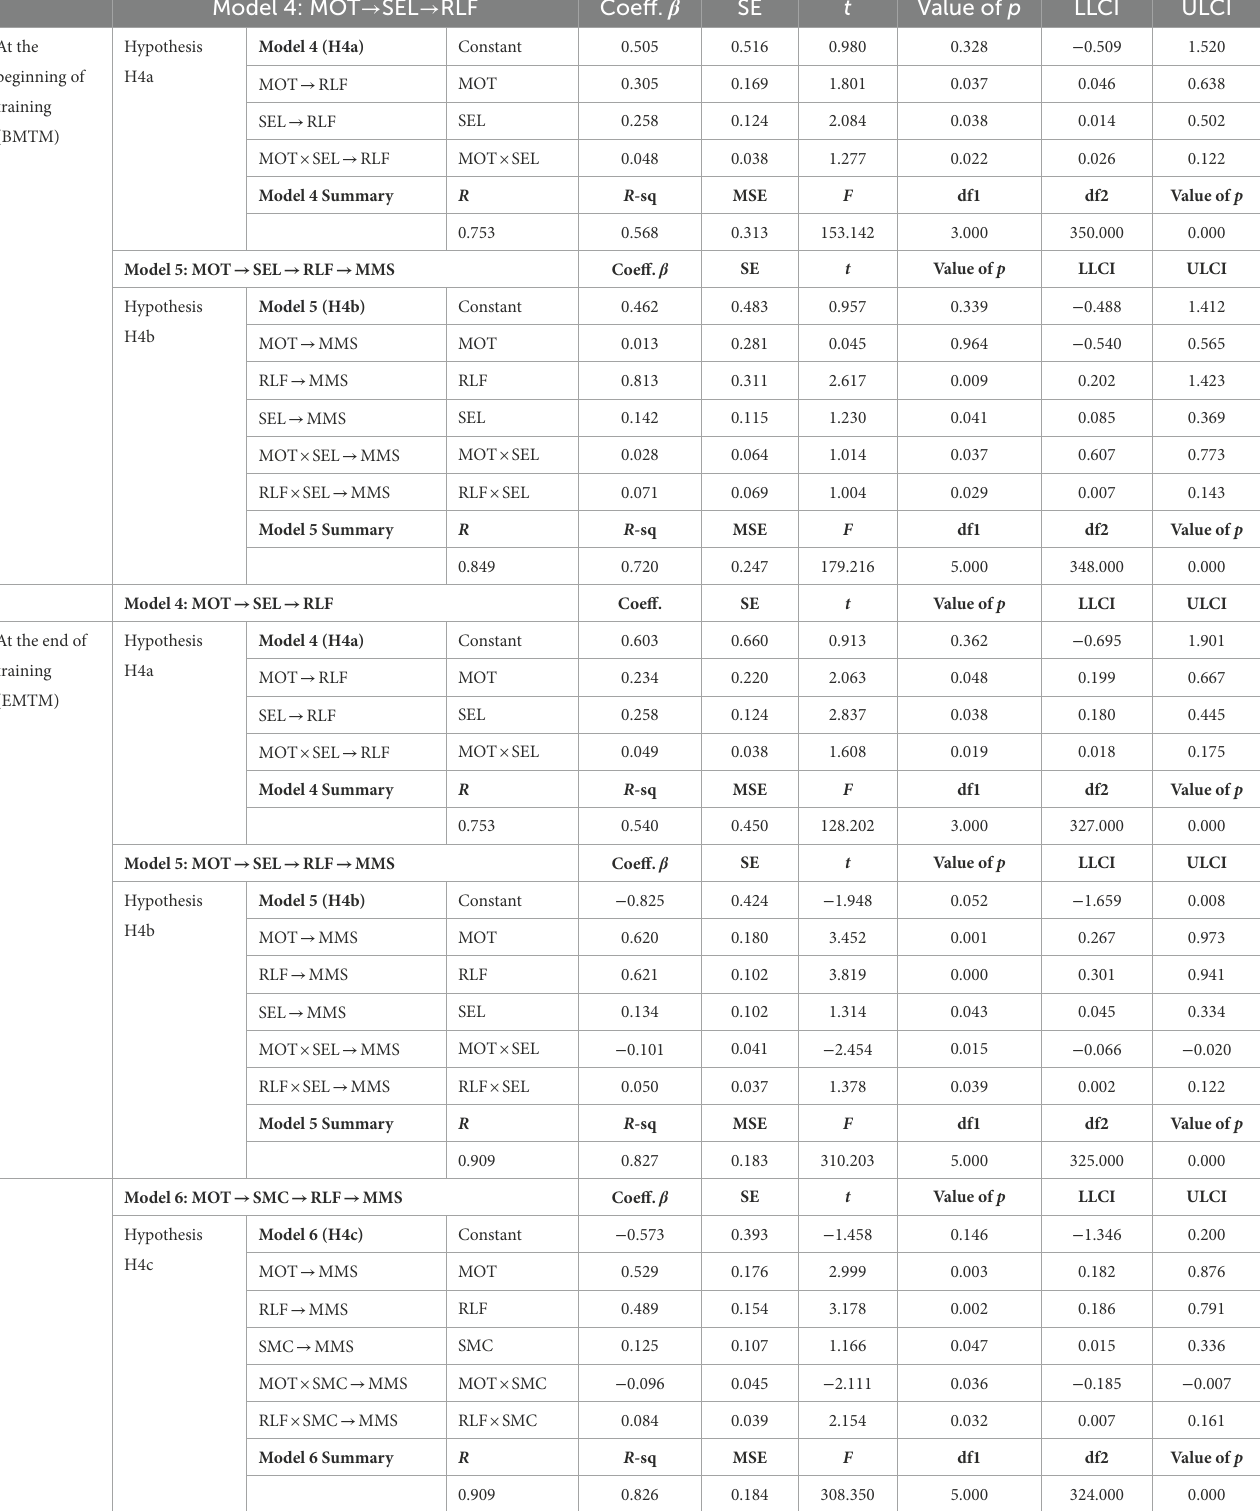
TABLE 6 The moderation effects of self-efficacy construct evaluated by using the PROCESS v3.5 macro-Model 59. Model 4: MOT → SEL → RLF Coeff.